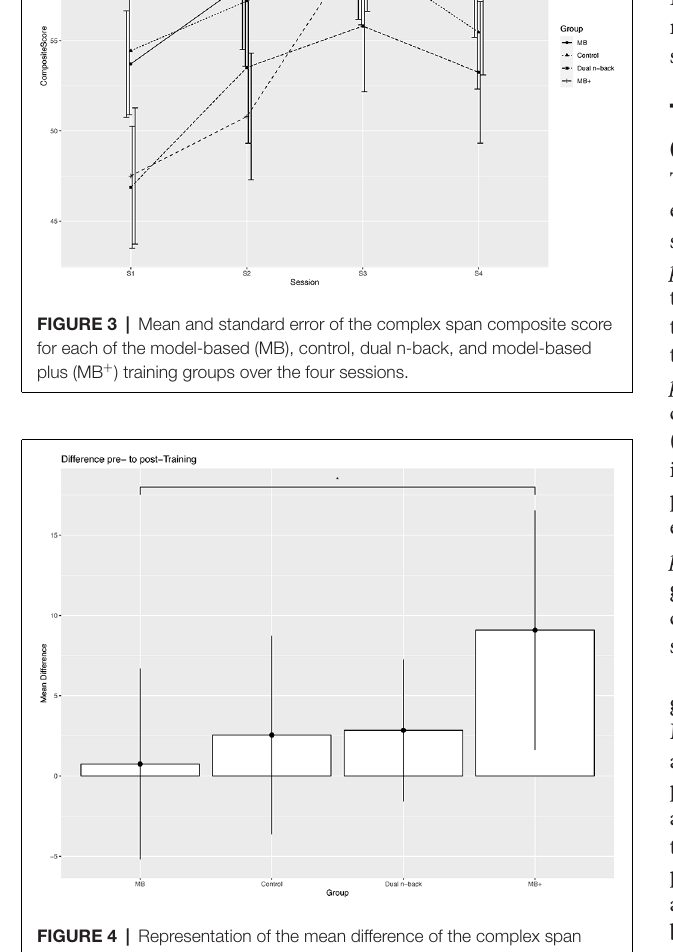
t (103) = 4.01, p < 0.001, r = 0.37), despite no training took